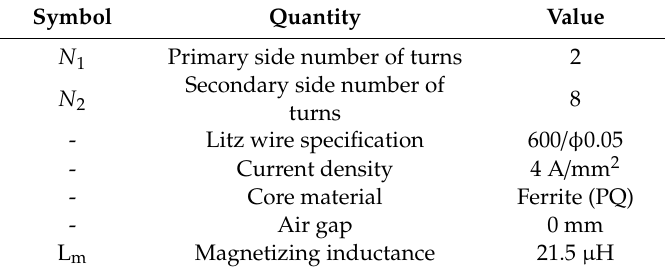
Table 4. Parameters of transformer